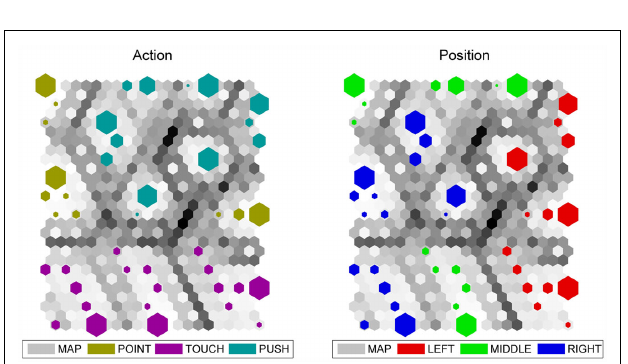
FIGURE 12 |The visualization of the activations on the actor’s hidden layer using the self-organized map with toroid topology. The two plots correspond to the same SOM, with different labels